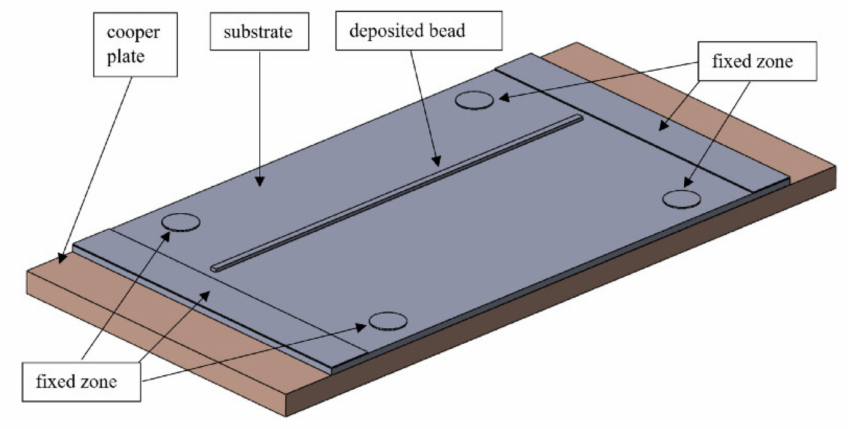
Figure 3. Geometrical model.